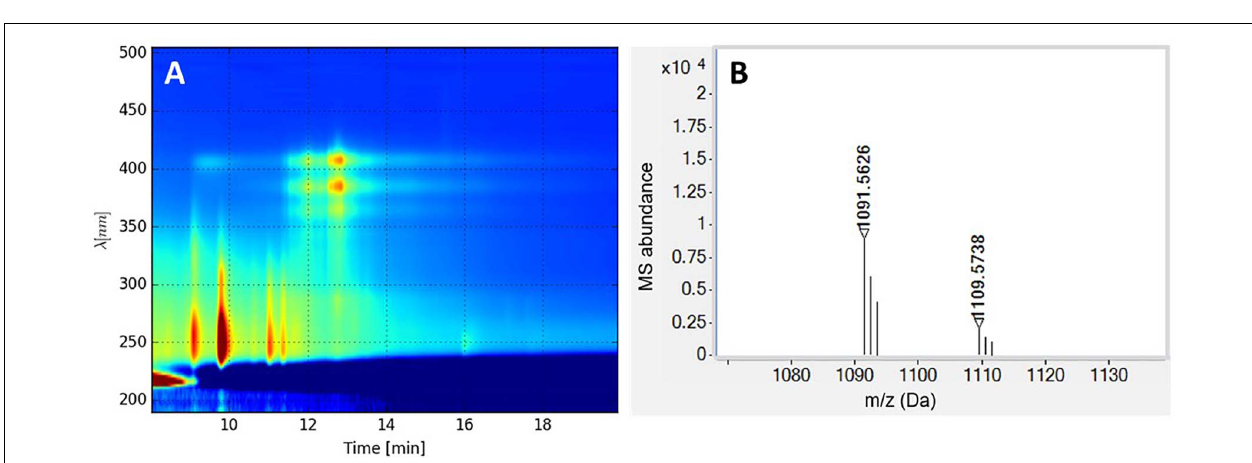
FIGURE 7 | (A) LC-diode array detector (DAD) isoplot of the analyzed extract showing candicidin at retention time 13–14 min. (B) MS spectrum (M + H) of candicidin and candicidin-H 2 O